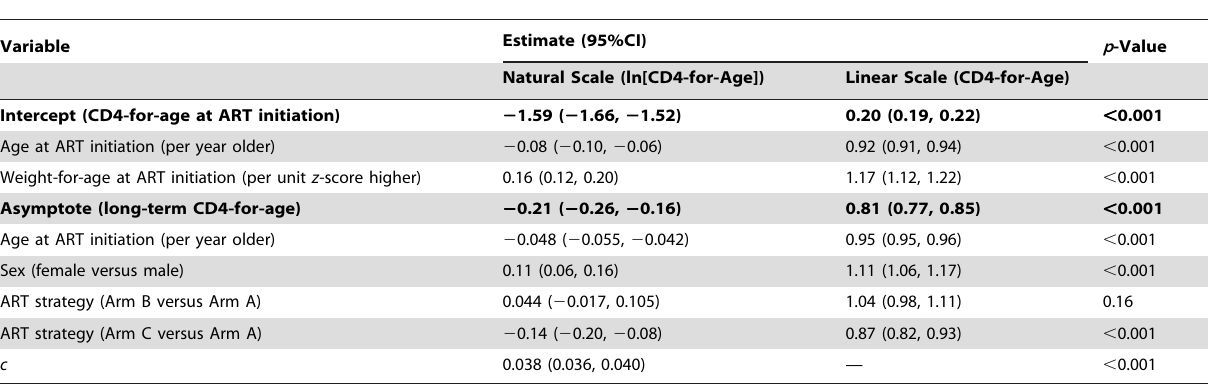
Table 2. Predictors of CD4-for-age after ART for 914 children with asymptotic CD4